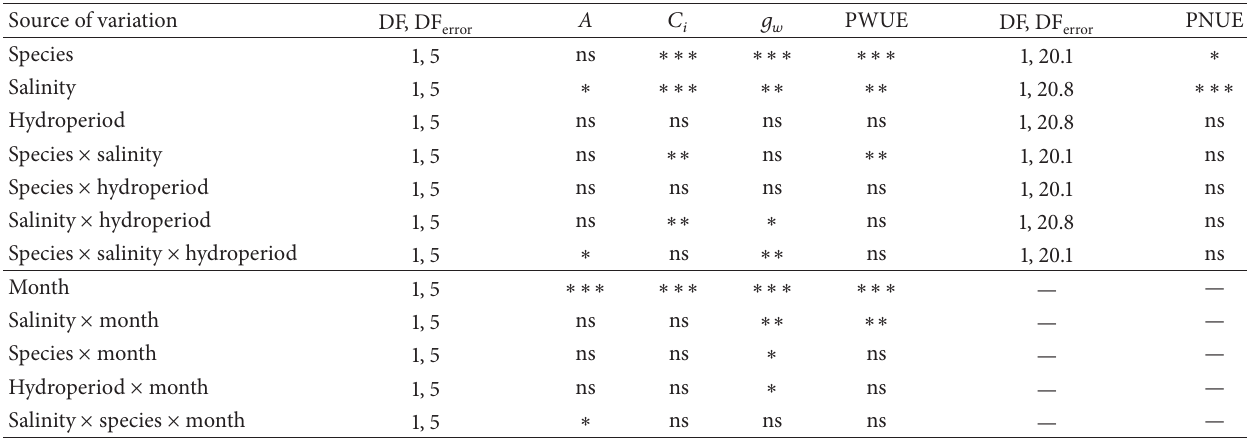
Table 1: Mixed model ANOVA results describing leaf gas exchange variables for seedlings of Rhizophora mangle and Laguncularia racemosa grown in mixed culture under different salinity and hydroperiod